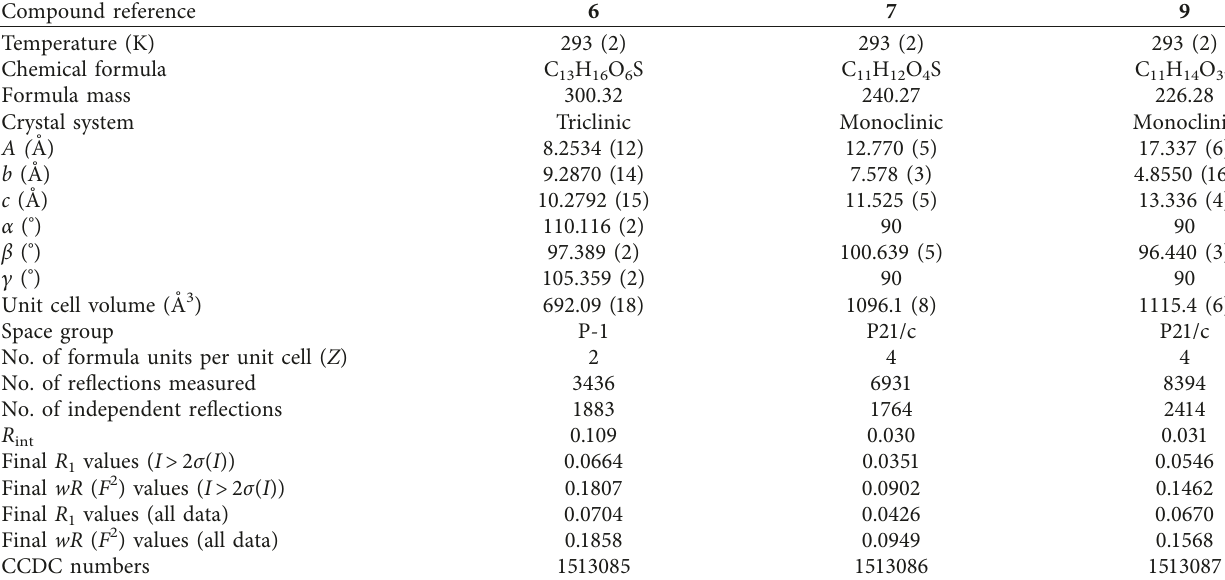
Table 1: Parameters of crystals of compounds 6 , 7 , and 9 and conditions of X-ray diffraction experiments. Compound